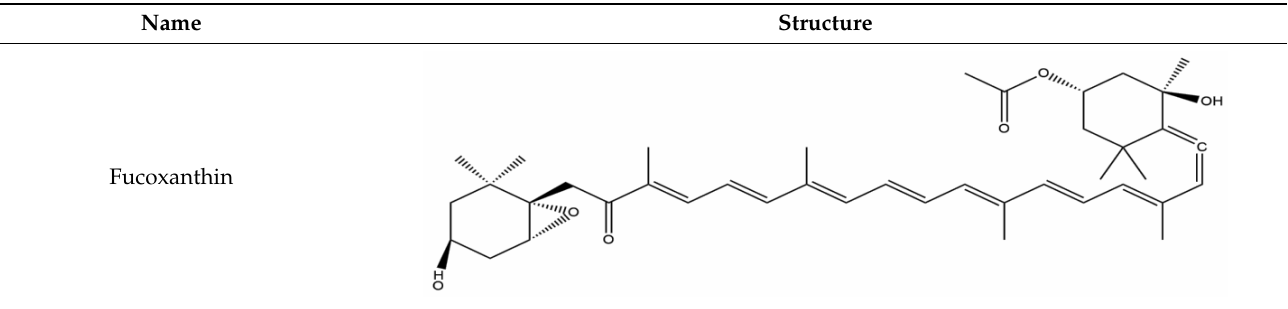
Table 3. The below table lists the marine drugs used in cardiovascular disorders with their respective